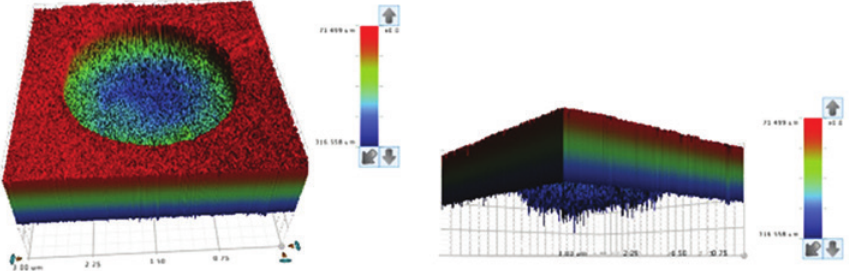
Figure 2: 3D profilometer example taken from the worn surface of a dental composite material.